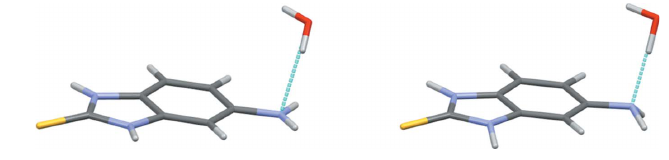
Figure 7 Configuration of the amino group in the structure of ODAXID calculated from the experimental data (Hadjikakou & Light, 2016) and obtained after optimization with a periodic